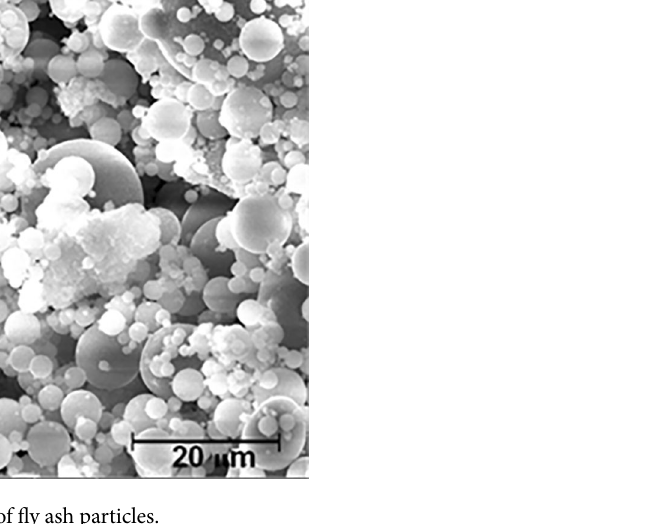
Figure 1. SEM micrograph of fly ash particles.